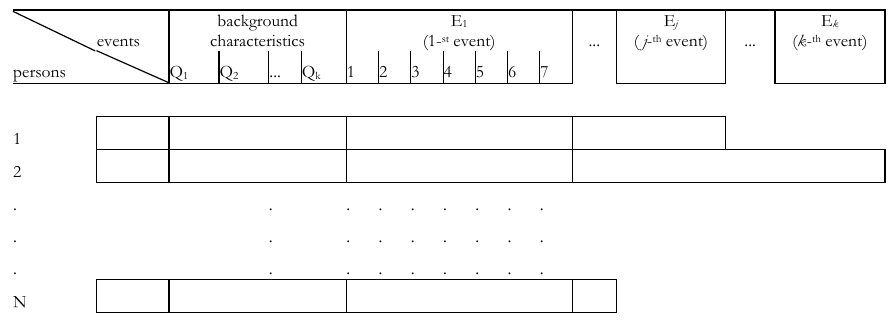
Time-Use Data File: coding at the level of